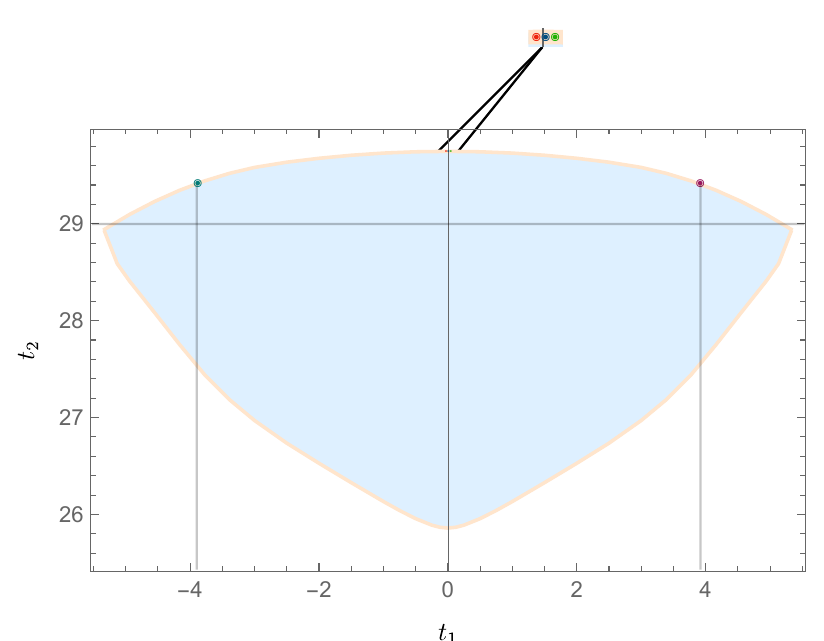
Figure 10: We show that the MC results from different starts give different results for t and t . This is consistent with the results in Ref. [ 22 ] that one will obtain an 1 2 entire line of solutions. We have shown data from five different MC runs by coloured ∼ 0 were obtained by starting from a trivial start i.e., circles. The three points near t 1 = ± 3.88 ( 2 ) and t = 29.41 ( 4 ) were obtained ( X , Y = 0) while the two points with t 1 2 by starting from X , Y = ± (cid:73) respectively. The figure is used after taking permission from the authors of Ref. [ 22 ]